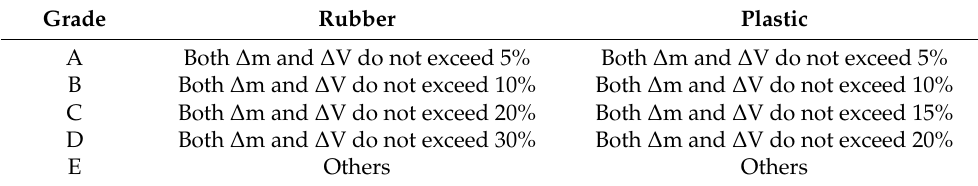
Table 3. Evaluation index of swelling resistance of polymer